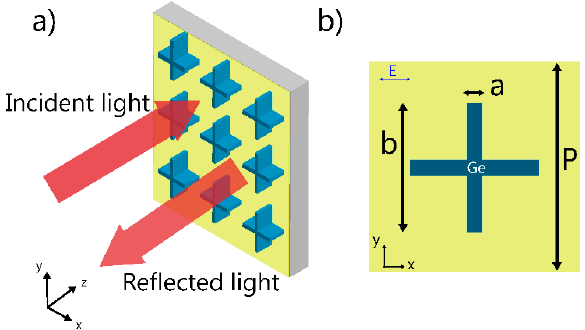
Figure 1. Perspective views of the hybrid metasurface absorber ( a ) and the unit cell ( b ). The height of the resonator is constant at h = 0.95 µ m; the period p and geometric parameters a and b vary for different resonance wavelengths.